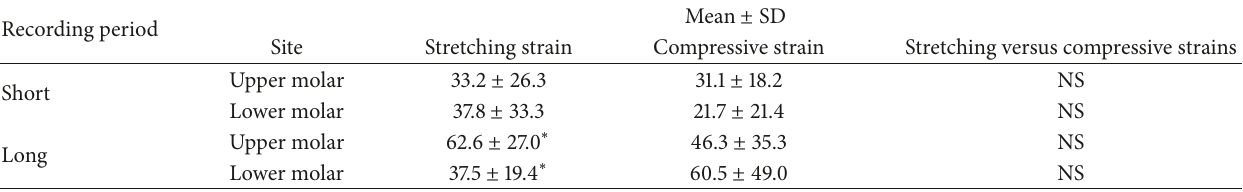
Table 2: Comparison of the strain on the first